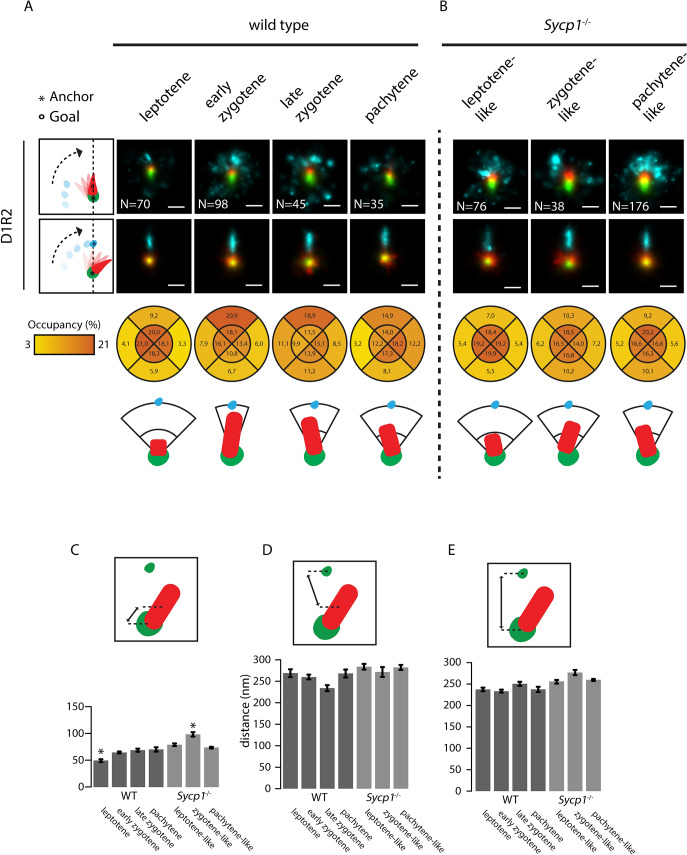
Consensus patterns of D1R2 during meiotic prophase in wild type and Sycp1-/- spermatocytes.Summed images of all rotated and aligned foci within the D1R2 group in wild type (A) and Sycp1-/- (B) per stage. Images were rotated as indicated by schematic drawings to the left of each row, whereby the anchor (*) indicates the nanofocus that is centred, and the goal (o) the nanofocus that is rotated to align along the axis. Underneath the lowest D1R2 row, the percentage of localizations for the DMC1 nanofocus in each indicated quadrant area is shown for each stage for the rotation whereby the close-RAD51 is used as anchor and the far-RAD51 as goal. A schematic interpretation of the results of the rotations is also shown. (C-E) Mean distances between the indicated nanofoci per stage in wild type and Sycp1-/- spermatocytes. Error bars indicate SEM. Asterisks indicate significant difference compared to all other stages (p<0.05). Scale bars represent 100 nm. p-values can be found in S2 Table.